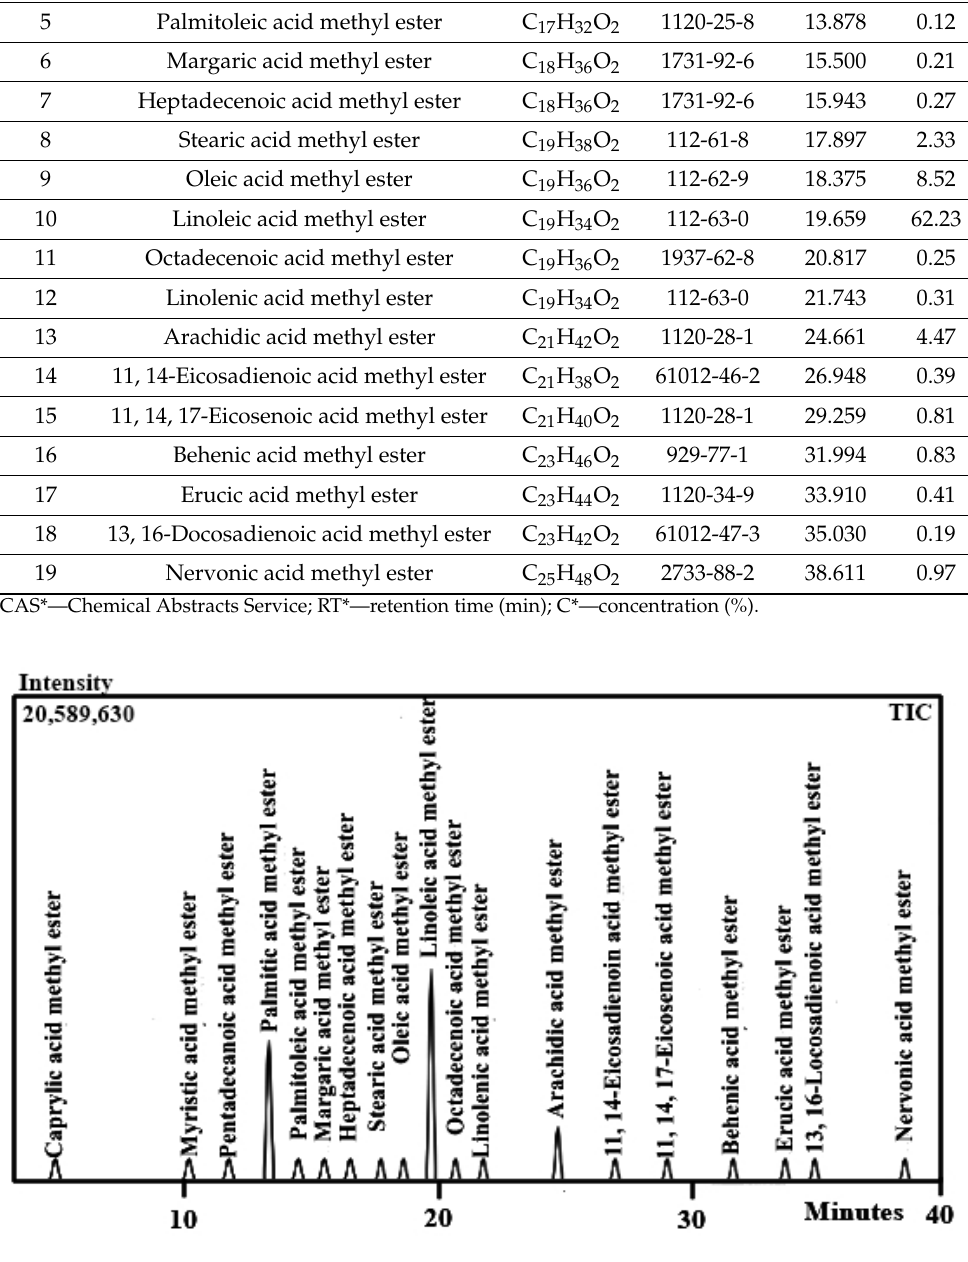
Figure 9. GC-MS analysis of SMB composition of different FAMEs formed in transesterification reaction.